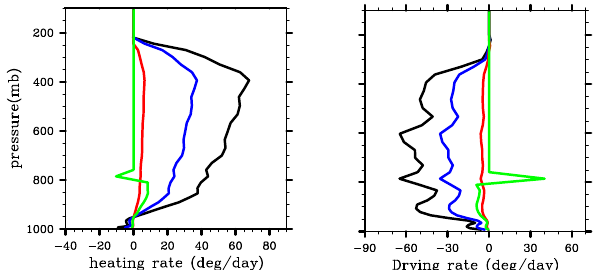
Figure 3: Heating rate (left), and drying rate (right), for grid resolution of 30km (black), 10km (blue), 3km (red) Figure 3. Heating rate (left), and drying rate (right), for grid reso- and 1km (green) lution of 30km (black), 10km (blue), 3km (red) and 1km It should be noted here that the 1km resolution test in 1-d maybe somewhat misleading in terms of the magnitude. In 3-d tests the convective parameterization will be automatically turned off if relative humidity is near saturation (95%) and vertical velocity is upward anywhere below the level of free convection. For the test sounding given in Figure 2 we have an upward vertical velocity which is explicitly used in two of the ensemble closures. In a 3-d model run the scheme would most likely be turned off for this grid box with the given sounding at high resolution, if forcing is present. We show the 1d tests to see the